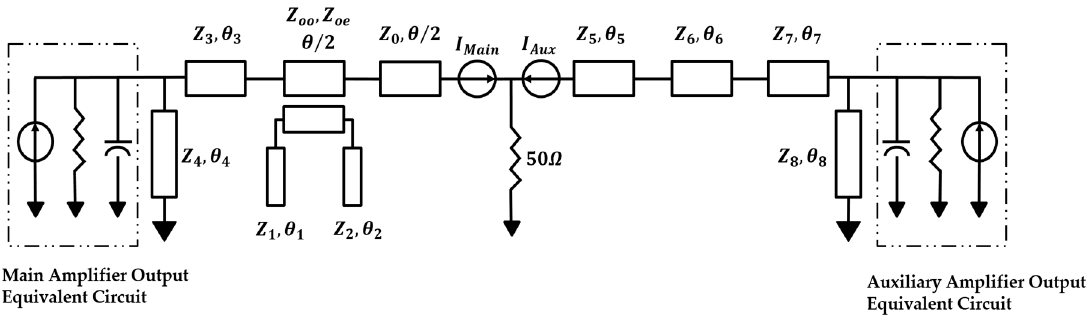
Figure 13. Final schematic used to optimize the complete output power combiner.